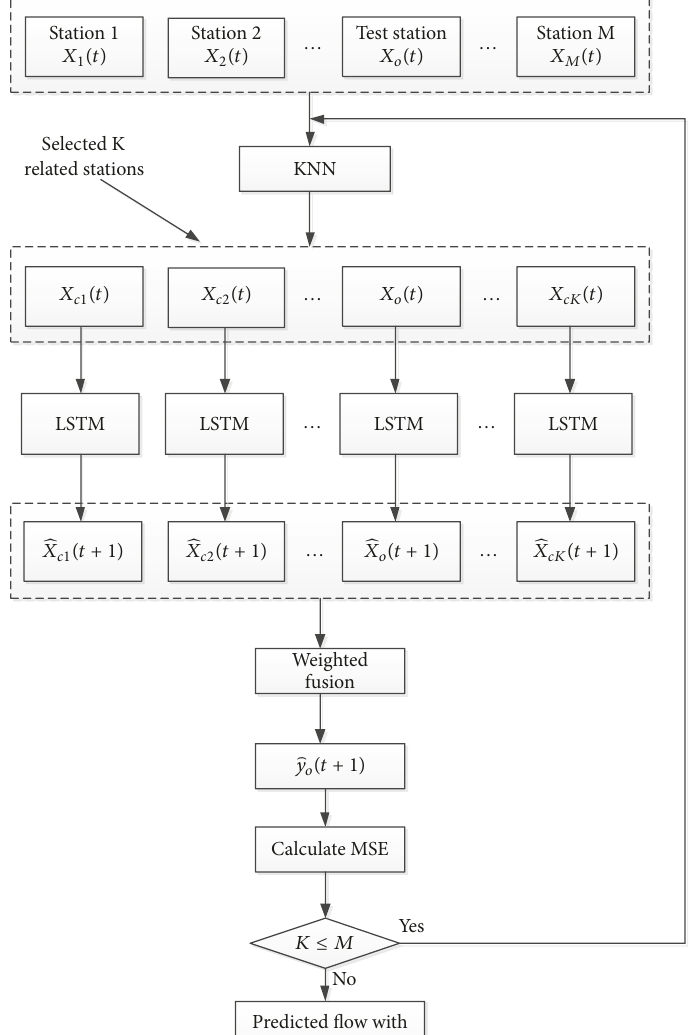
Figure 2: The flowchart of the proposed